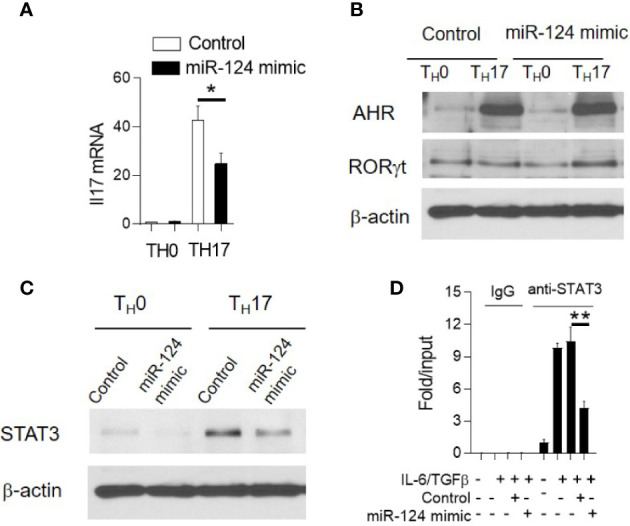
miR-124 suppresses TH17 activation by targeting STAT3. Naïve CD4+ T cells from C57BL/6 mice were differentiated under TH17 and TH1 polarizing conditions with IL-6 (10 ng/ml) and TGFβ (5 ng/ml) for 24 or 72 h in the presence of 4.8 nmol miR-124 mimic. (A), miR-124 expression was detected by qPCR, U6 as control. (B, C) The whole cell lysates were prepared, and western blotting was performed for the analysis of protein expression. B-actin expression serves as a control. (D) El4 cell was stimulated with CD3 and CD28 antibody and primed with IL-6 and TGFβ in the presence of miR-124 mimic. Chip assay was performed with anti-STAT3 antibody, IgG antibody as negative control. *p < 0.05; **p < 0.05, miR-124 mimic vs Control in the present of IL-6/TGFβ. The results are representative of three independent experiments.